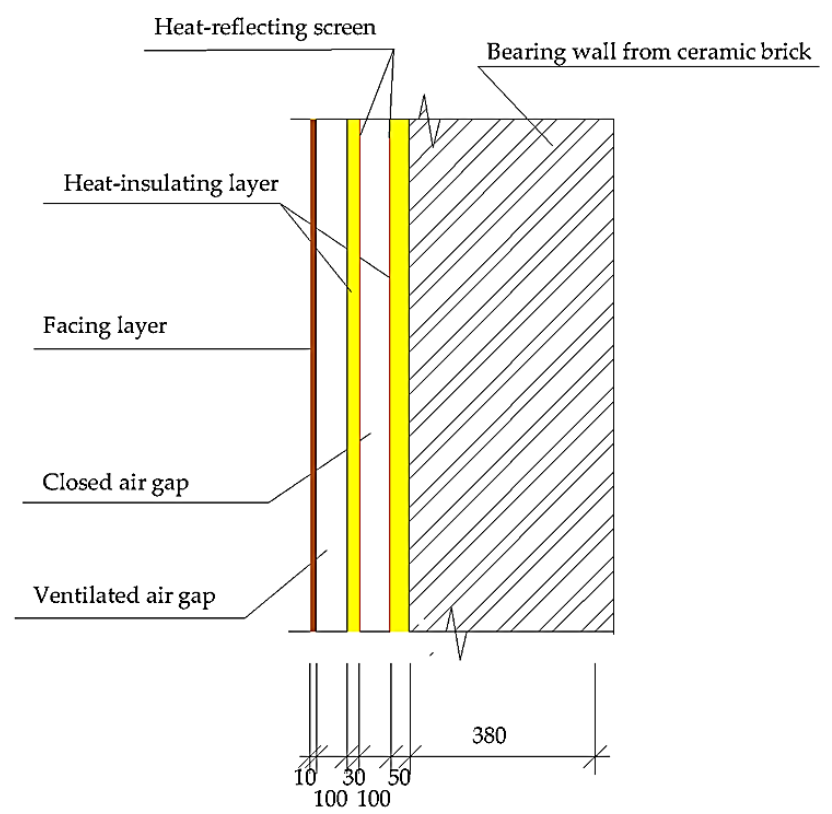
Figure 4. multilayer wall enclosing structure with homogeneous bearing, heat-insulating layers and ventilated air gaps with a heat-reflecting screen-aluminum foil on the inner and outer surfaces of a closed air gap (the thickness of the layers of the structure is given in millimeters).